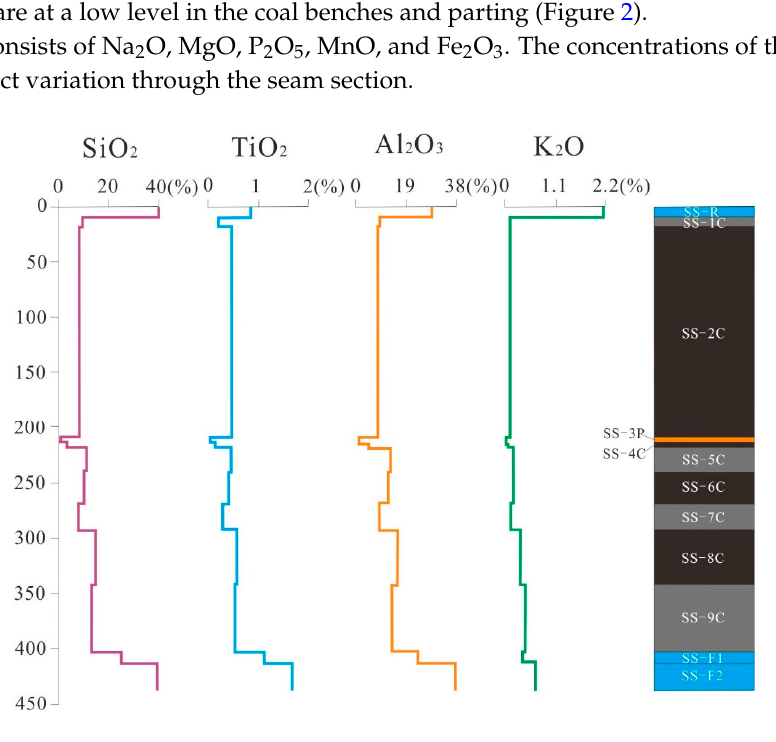
Figure 2. Variations of SiO 2 , TiO 2 , Al 2 O 3 and K 2 O through the seam